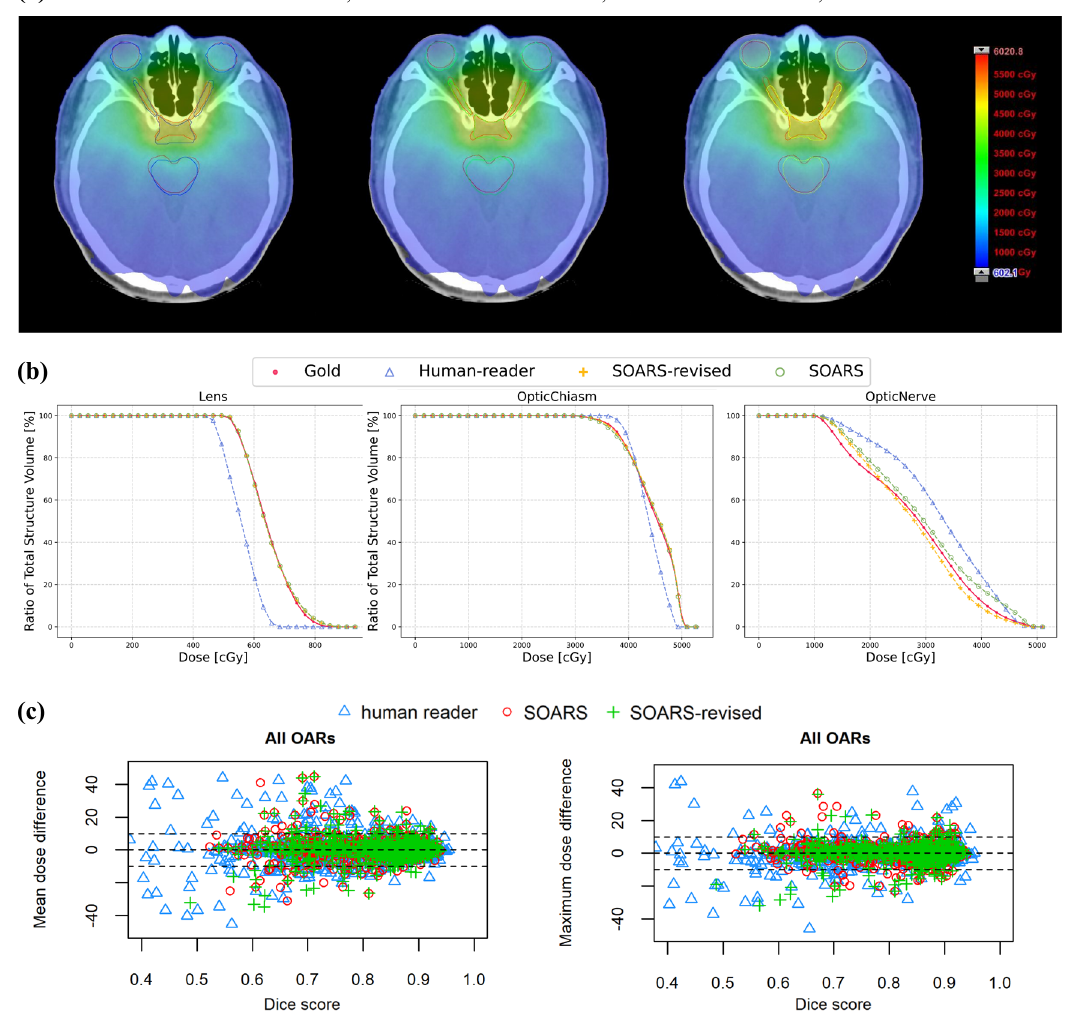
Fig. 4 | OAR dosimetric illustrations. Using a speci fi c patient, without loss of generality,weillustrateaqualitativelydirectdosimetricexample a inaxialviewsof two anatomic locations. Clinical OAR reference: red; human reader: blue; SOARS OAR: green; SOARS-revised: yellow. b the dose – volume histograms (DVH) plot of OARs in this patient. c The scatter plots of direct mean dose differences Diff direct meandose anddirectmaximumdosedifferences(Diff direct maxdose )broughtbyvarious